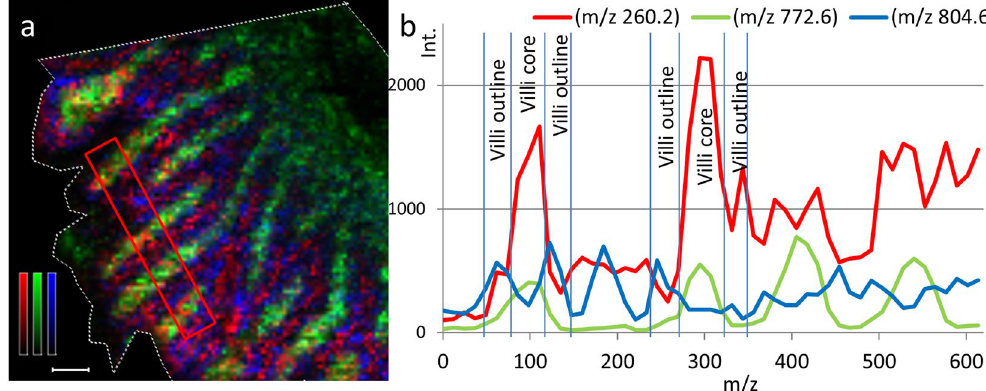
Figure 4. Ion distribution image and transverse profile of propranolol in rat small intestine villi following oral administration. ( a ) Ion distribution images of propranolol (m/z 260.2) together with two different villi markers; m/z 772.6 represents lamina propria region and m/z 804.6 represents the zone of the epithelial cells of the villi outline. Propranolol is represented by a red monochrome colour scale; scaled to 10% of max intensity, m/z 772.6 is represented in green; scaled to 60% of max intensity, and m/z 804.6 is represented in blue; scaled to 20% of max intensity. Scale bar is 100 µ m. ( b ) The intensities of propranolol (red), m/z 772.6 (green), and m/z 804.6 (blue) are also represented by line